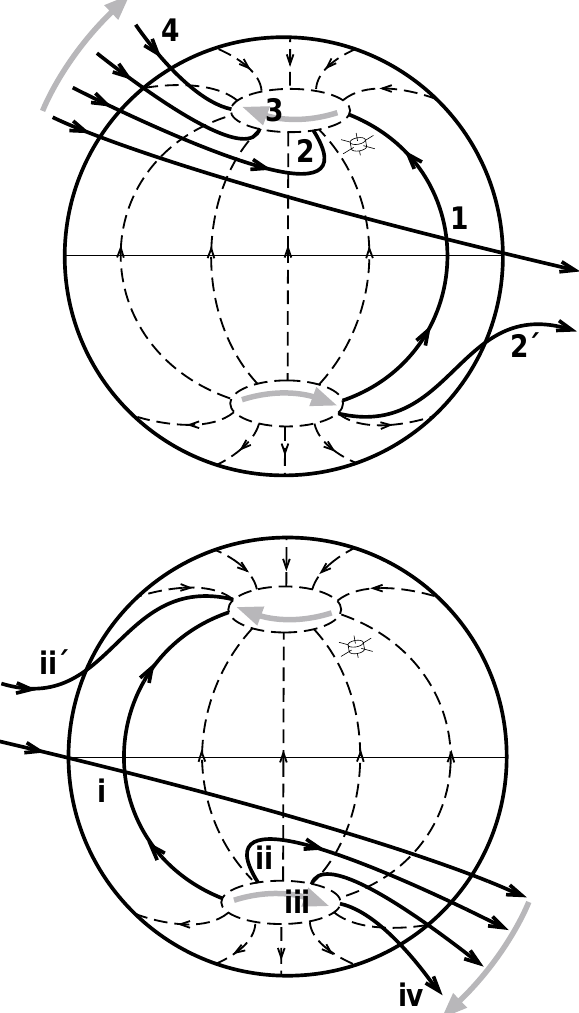
Fig. 4. Sketch of the Earth’s dayside magnetopause in a view look- ing from the Sun, showing (a) the temporal evolution of an open flux tube (solid lines marked ‘1’–‘4’) following a low-latitude re- connection event in the dusk sector (near ‘1’) and (b) the temporal evolution of an open flux tube (solid lines marked ‘i’–‘iv’) follow- ing a low-latitude reconnection event in the dawn sector (near ‘i’). The grey arrows indicate the direction of open field line motion, in- cluding westward motion in the northern cusp and eastward motion in the southern cusp. The arrowed short-dashed lines indicate mag- netospheric field lines within the magnetopause boundary region. We also indicate the approximate location of the Cluster